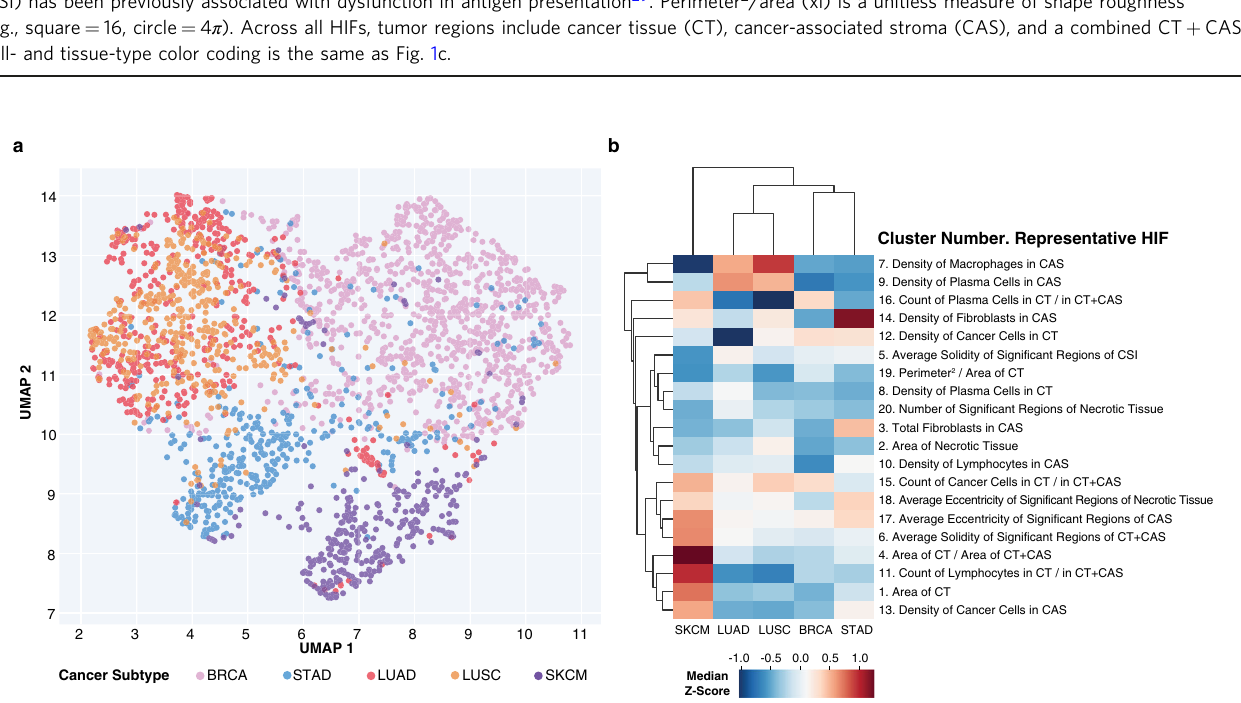
Fig. 4 HIF differences across cancer types. a Uniform Manifold Approximation and Projection (UMAP) visualization of fi ve cancer types reduced from the 607-dimension space de fi ned by human-interpretable image feature (HIF) values into two dimensions. Each point represents a patient sample colored by cancer type. b Clustered heatmap of median Z -scores (computed pan-cancer) across cancer types for 20 HIFs, each representing one HIF cluster (de fi ned pan-cancer). Hierarchical clustering was performed using average linkage and Euclidean distance. Clusters are annotated with a representative HIF chosen based on interpretability and high variance across cancer